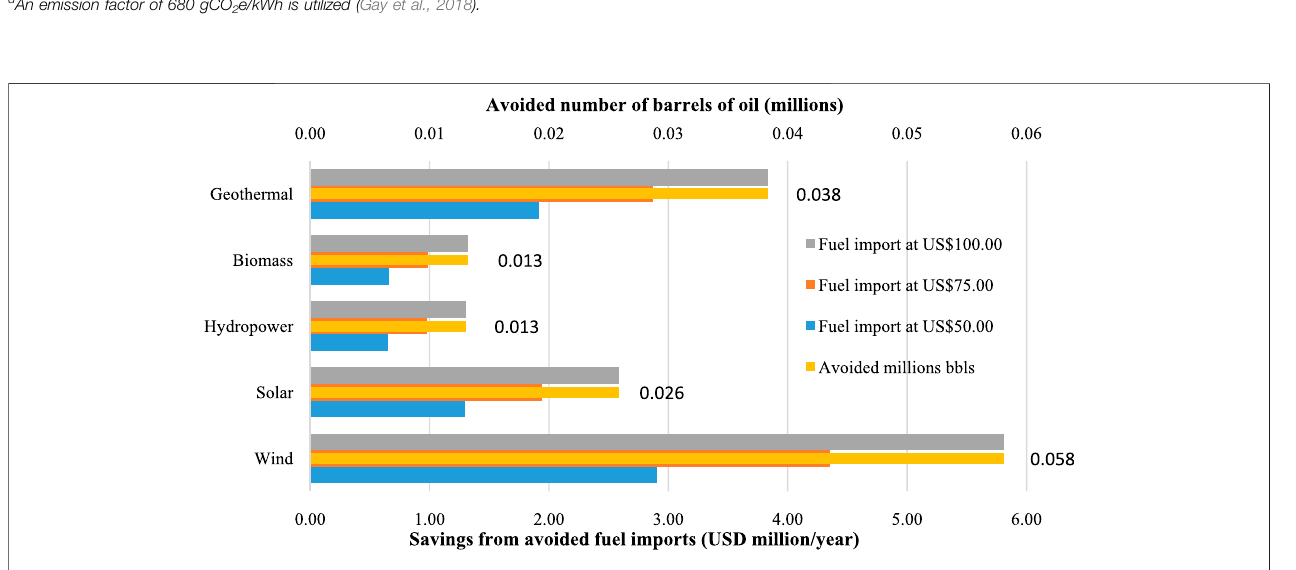
FIGURE 3 | Projected scenarios of avoided fuel importation prices through renewable